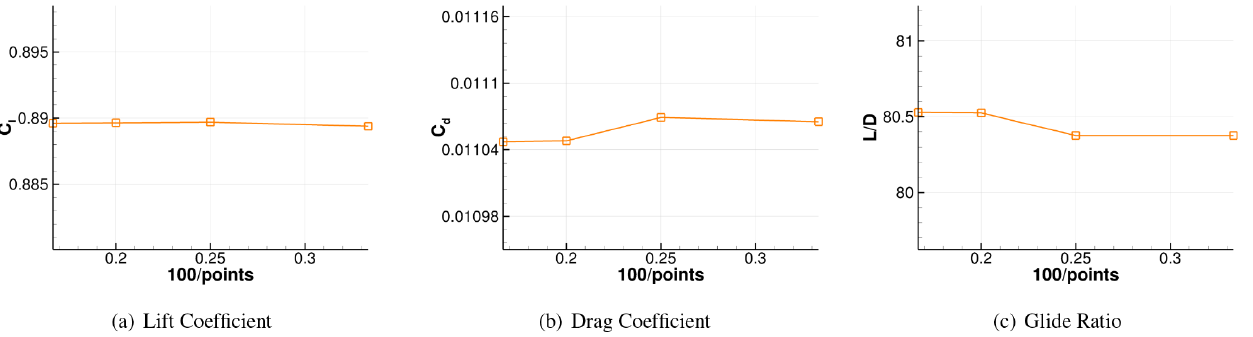
Figure B2. Grid resolution study for the DU93-W-210LM airfoil at α = 4 ◦ and Re = 9 × 10 6 (free-transition results using the one-equation